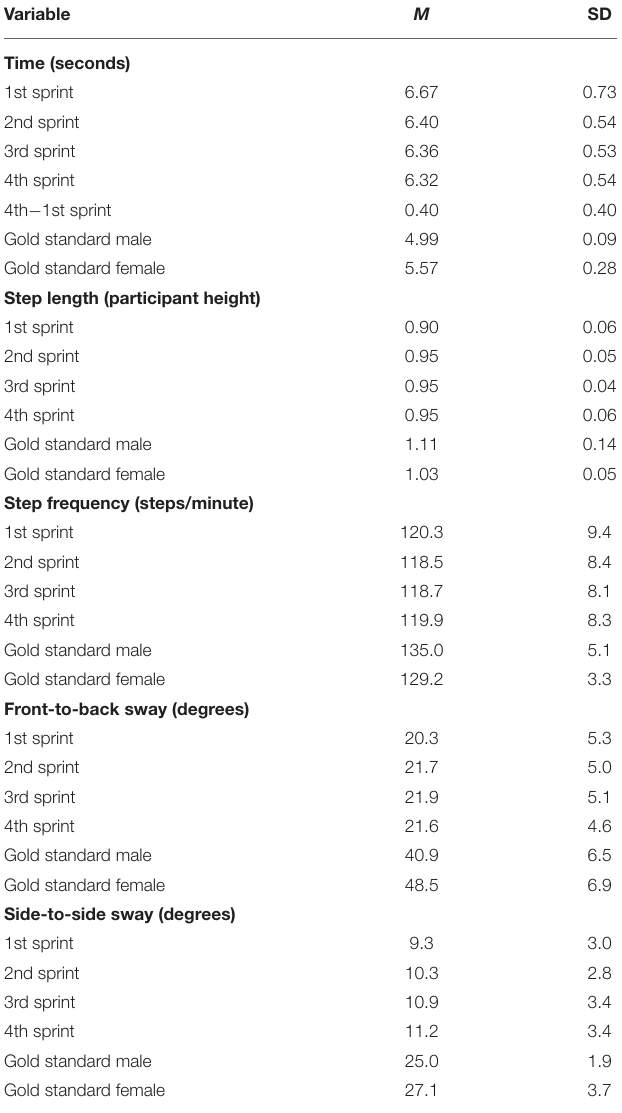
TABLE 1 | Descriptive statistics of biomechanical variables for Phase I and II participants.